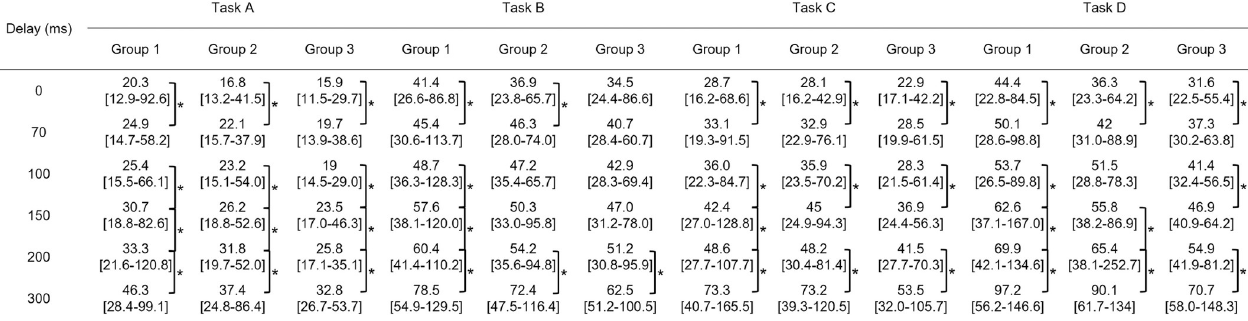
Fig 4. Task completion time for each Group under each delay. � shows significant difference (P value < 0.05). Values are median [minimum-maximum].